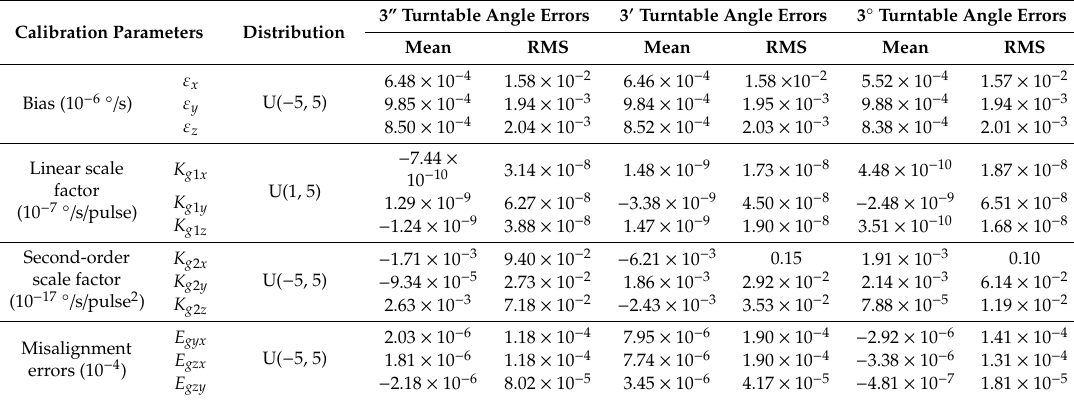
Table 3. Statistical results of Monte Carlo simulations for